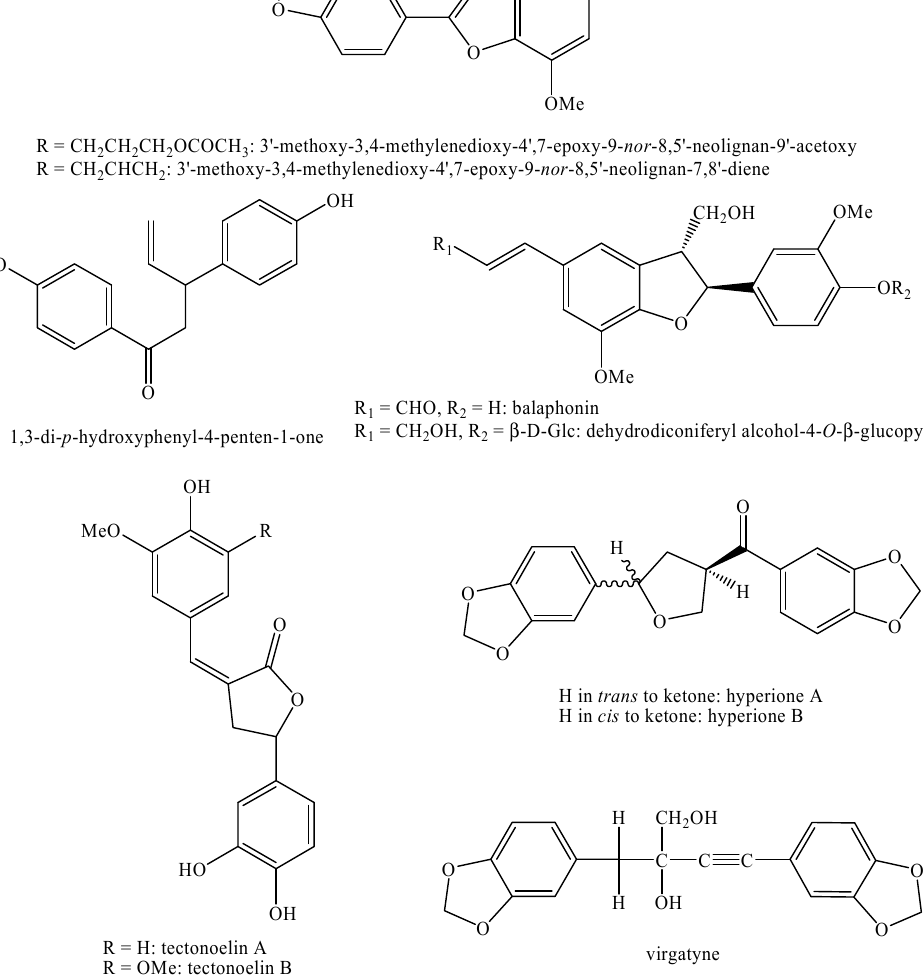
Figure 5. Isolated nor -lignans in the plant kingdom—part 4.